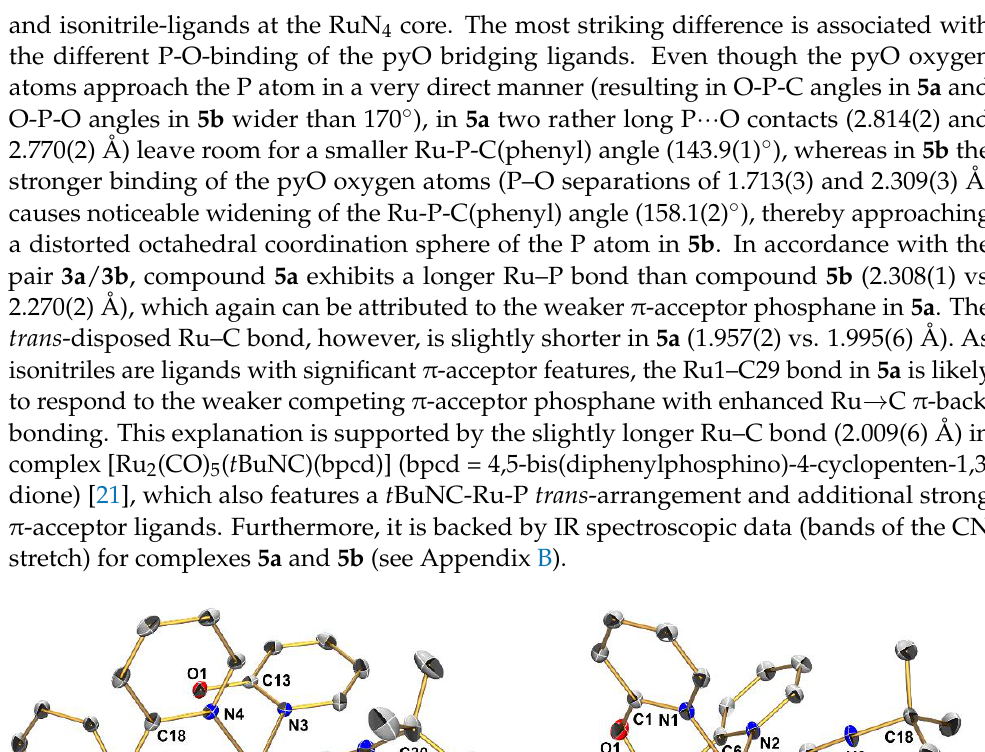
Figure 4. Comparison of corresponding interatomic separations (Å ) in the molecular structures of 4a and 6a (data for the molecules shown in Figure 3).